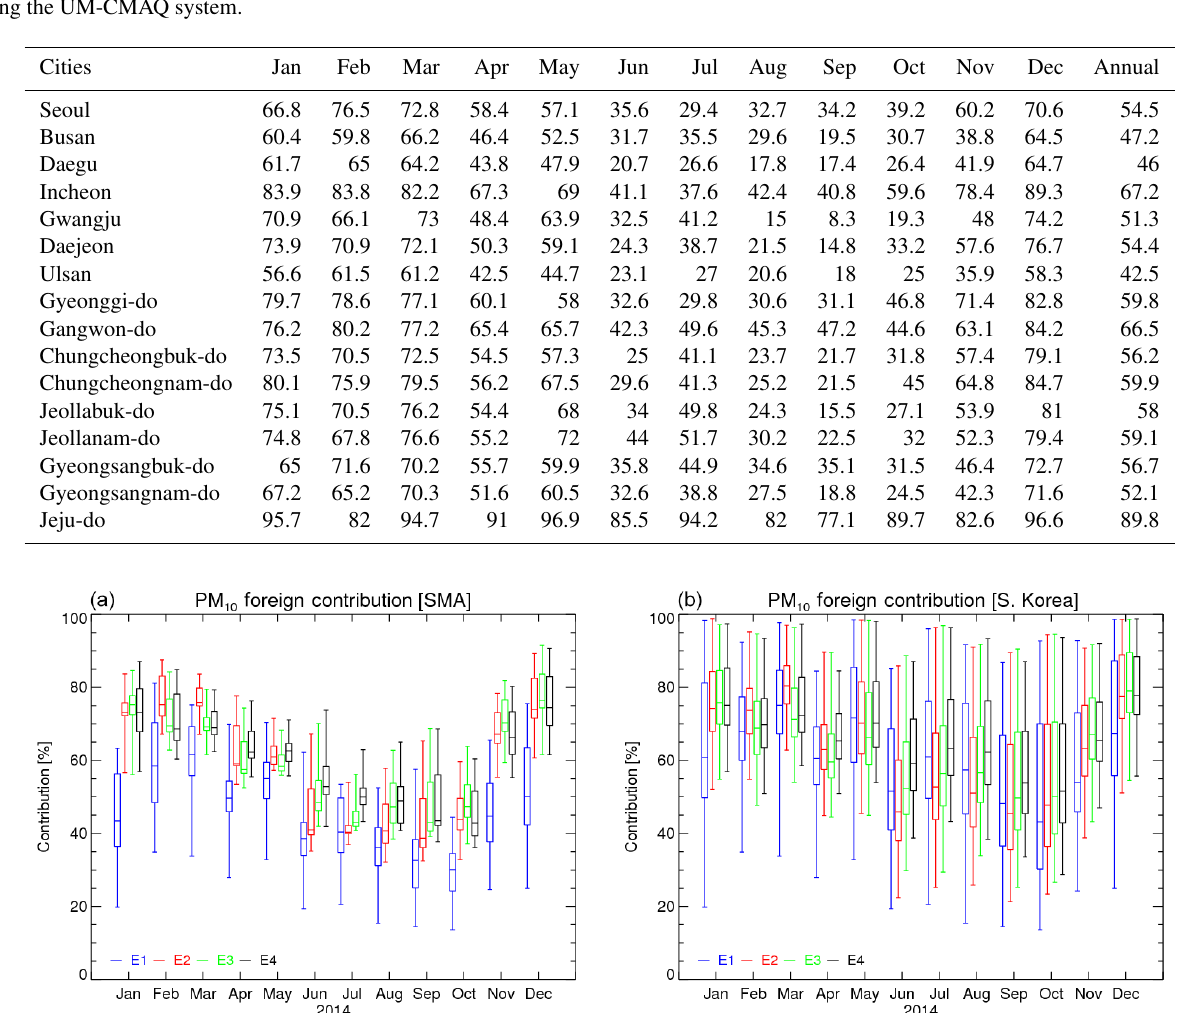
Table 6. Summary of foreign contributions (%) to surface PM concentrations for each month over major cities and provinces in South Korea using the UM-CMAQ system.